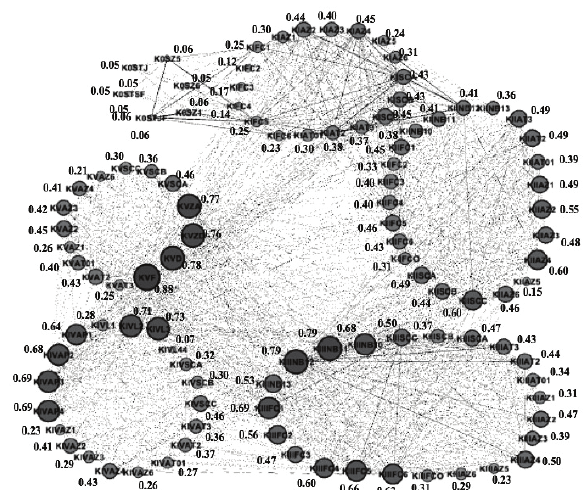
FIGURE 2. Network with Eigenvector Centrality for all variables related to the efficacy 1 in women’s volleyball. Terminology: in each node, codes are represented by the name of complex (e.g., KII), followed by the variable and its category (e.g., KIIAZ6 indicates that the action occurred in complex II, the variable in question was Attack Zone, and the category is Zone 6). Codes for the different variables: IPS – Initial Position of the Serve; ST – Serve Type (Jump, Jump-Float and Standing-Float); FC – Zone of First Contact; SC Setting Condition; AZ –Attack Zone; AT – Attack Tempo; BO – Block Opposition; KIVB – Number of Available Player Before of Attack Coverage; KIVL – Number of Coverage Lines; KVD and KVF – Downball and Freeball; KVTZ –Target Zone in KV (Attack or Defence Zone). Eigenvector values have highlighted for Efficacy 1 (i.e., conti-